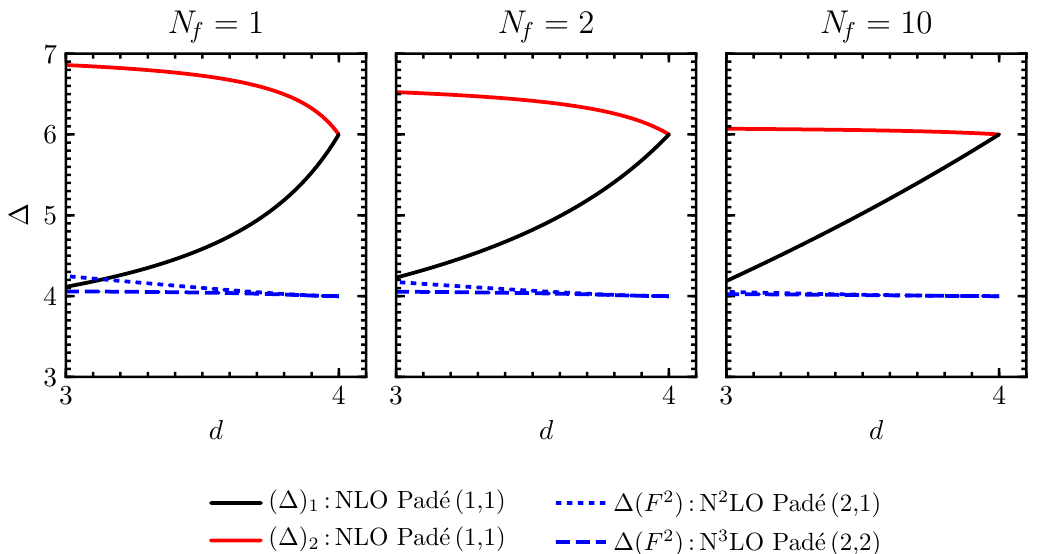
Figure 3 . (cid:15) -expansion approximations to the scaling dimensions of the two (cid:13)avor-singlet four- fermion operators (black and red lines) and F 2 (blue lines) as a function of the dimension d , i.e., (cid:22)(cid:23) for (cid:15) 2 [0 ; 1 ]. The left, center, and right panel show the result for the representative cases of 2 N f = 1 ; 2 ; and 10, respectively. We observe that the N 3 LO Pad(cid:19)e (2,2) prediction of (cid:1)( F 2 ) never crosses the NLO Pad(cid:19)e (1,1) prediction of ((cid:1)) 1 in the extrapolation